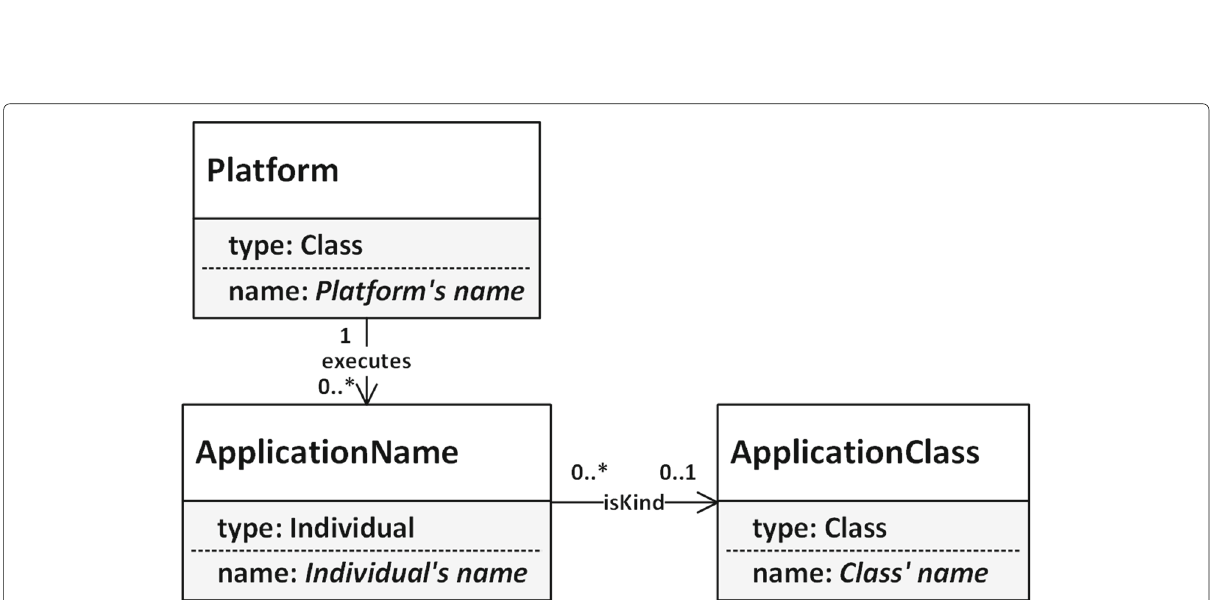
Fig. 5 Classification of